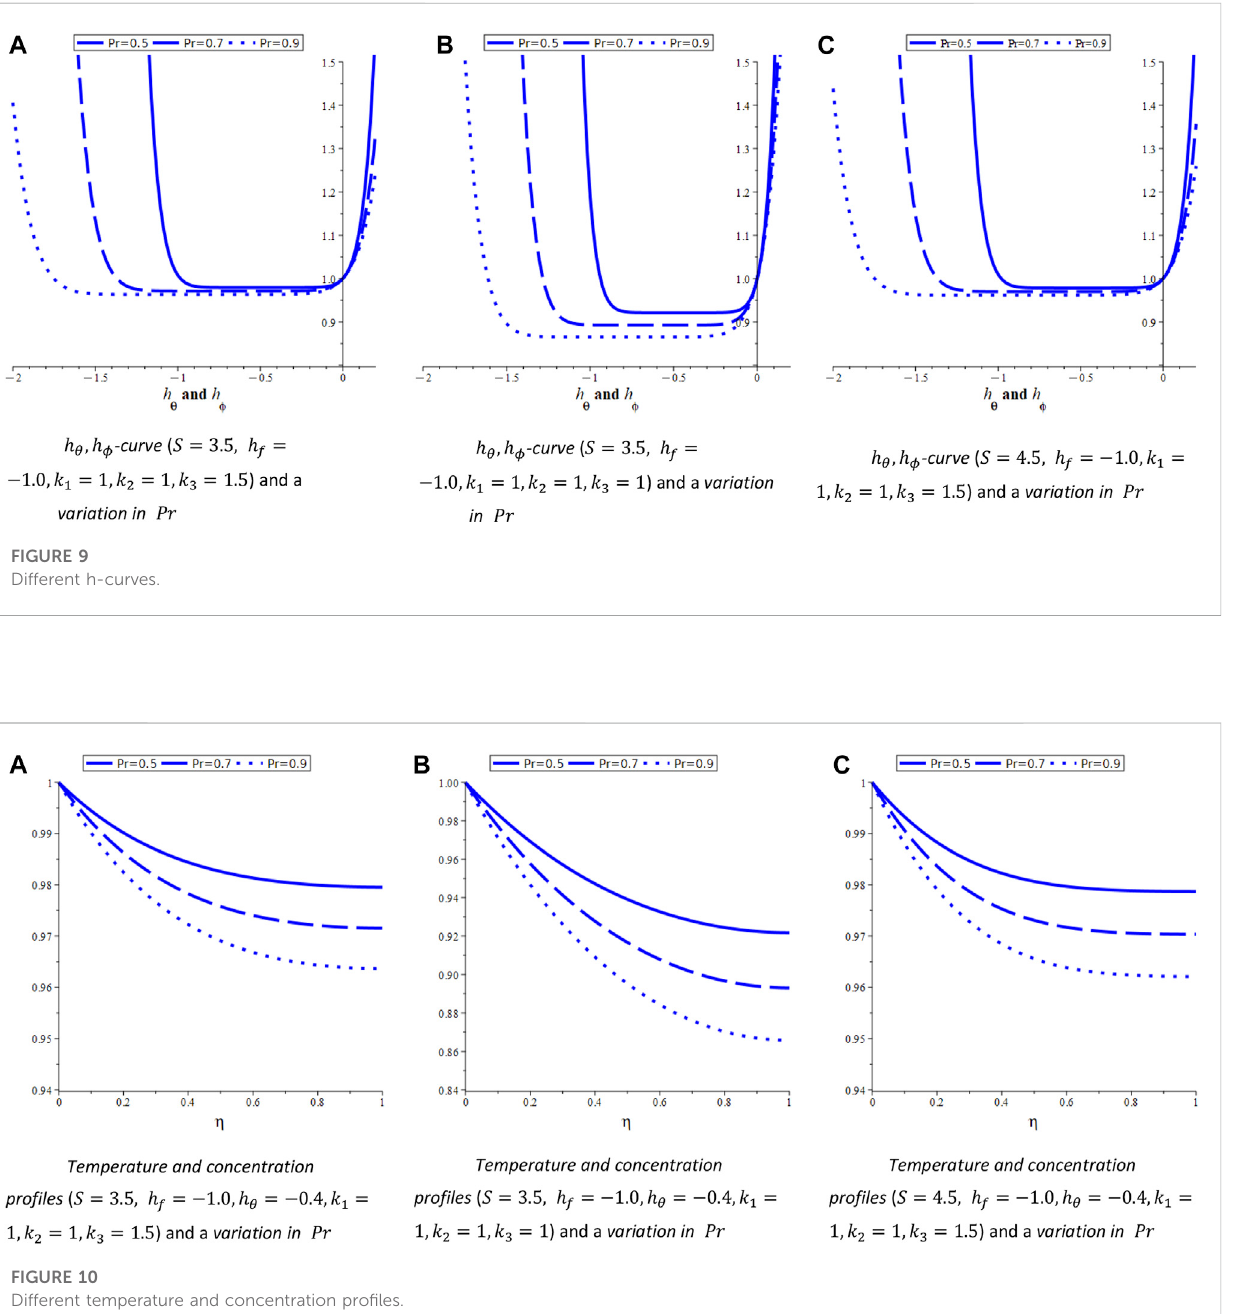
Different temperature and concentration pro fi